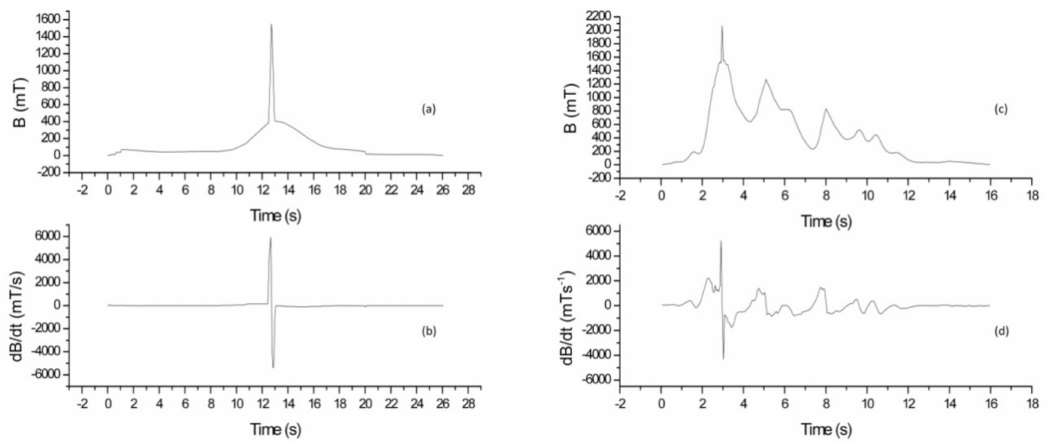
Figure 2. Measurement related to the TSMD_2 dosimeter, used on a 3.0 T site, placed on the head of two MRI technicians. The data were recorded during a simulation of an emergency. ( a , c ) the exposure is shown and ( b , d ) the corresponding computed dB/dt curve is represented.